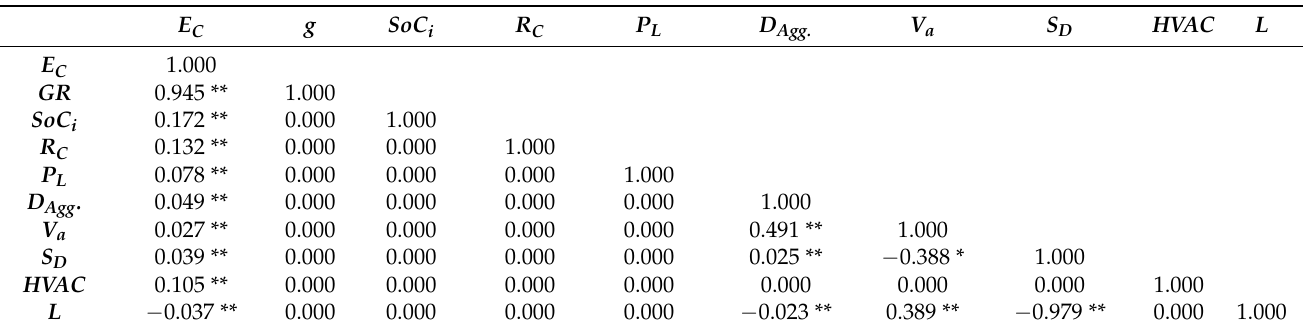
Table 6. The correlation matrix for the utilized parameters.